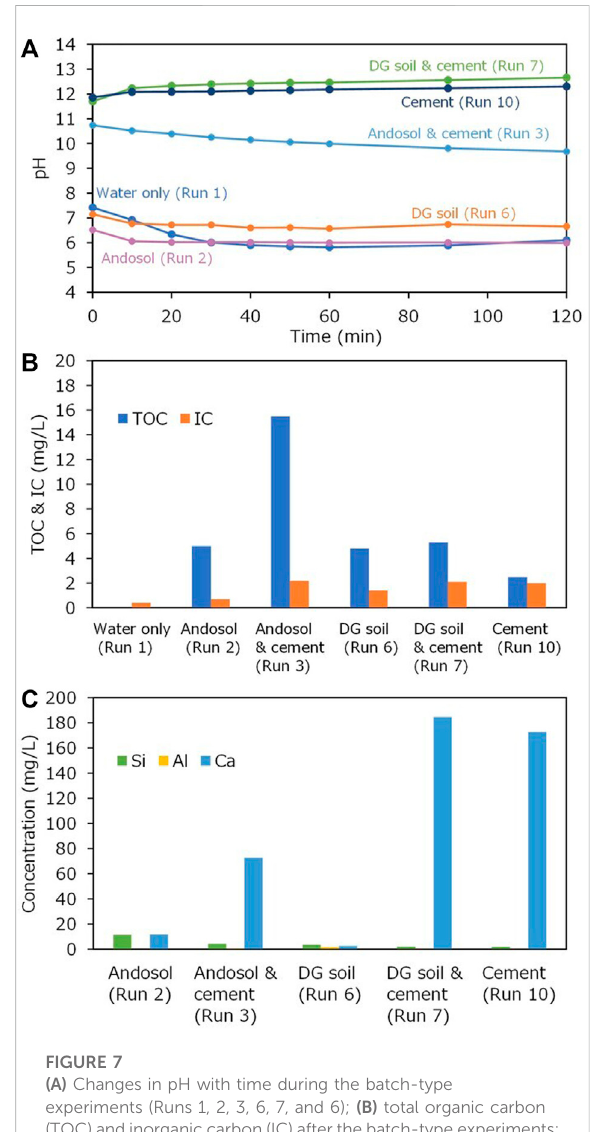
FIGURE 7 (A) Changes in pH with time during the batch-type experiments (Runs 1, 2, 3, 6, 7, and 6); (B) total organic carbon (TOC) and inorganic carbon (IC) after the batch-type experiments; and (C) Si, Al, and Ca concentrations for the liquid samples obtained after the